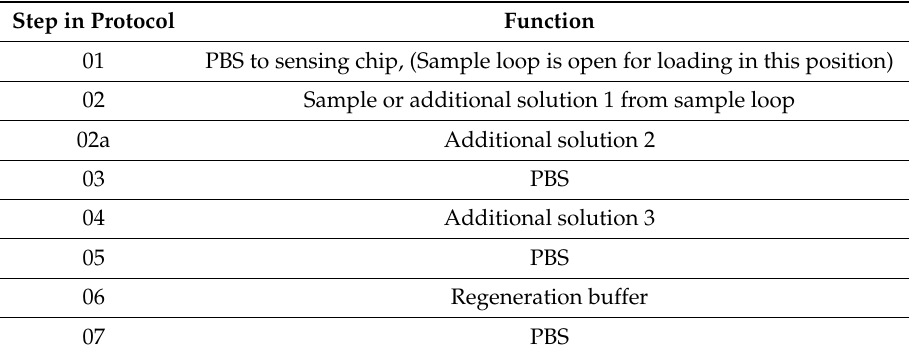
Table 1. The potential protocol to which the rotary valve was designed for different fluids measurements (an example is described in Table 1).